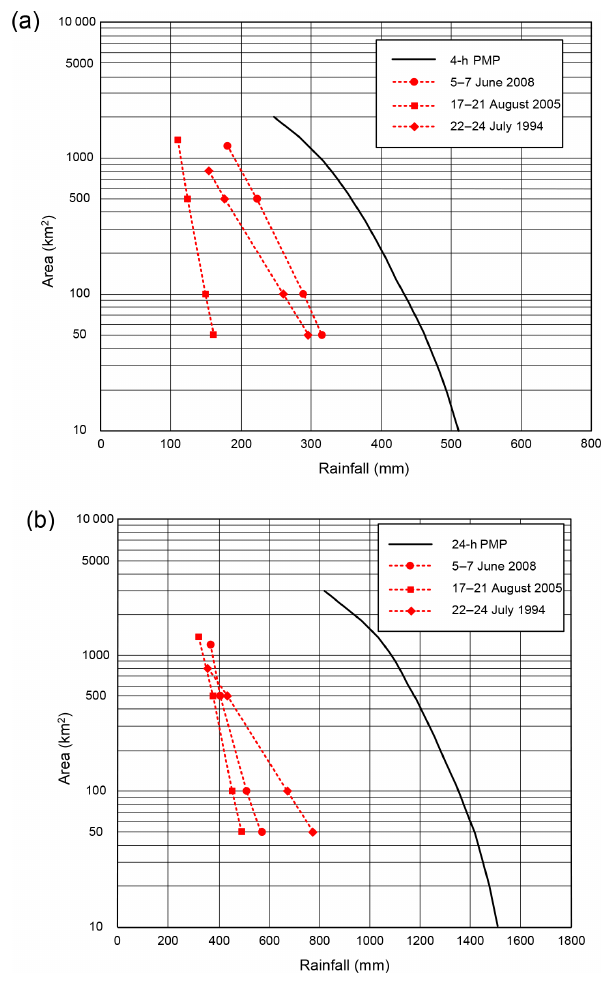
Figure 8. Magnitudes of the three storms characterized by (a) 4h PMP and (b) 24h PMP (modified from AECOM and Lin,